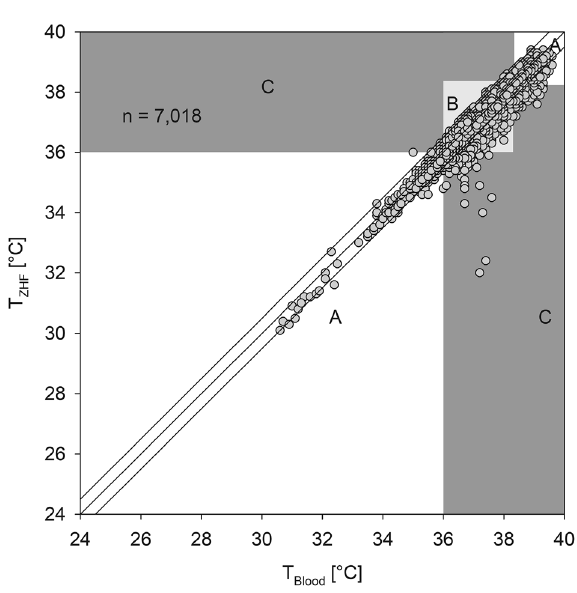
Figure 3. Error grid analysis of the zero-heat flux thermometer (ZHF) against blood temperature (T Blood ). Zone A is drawn in white, Zone B in grey and Zone C in dark